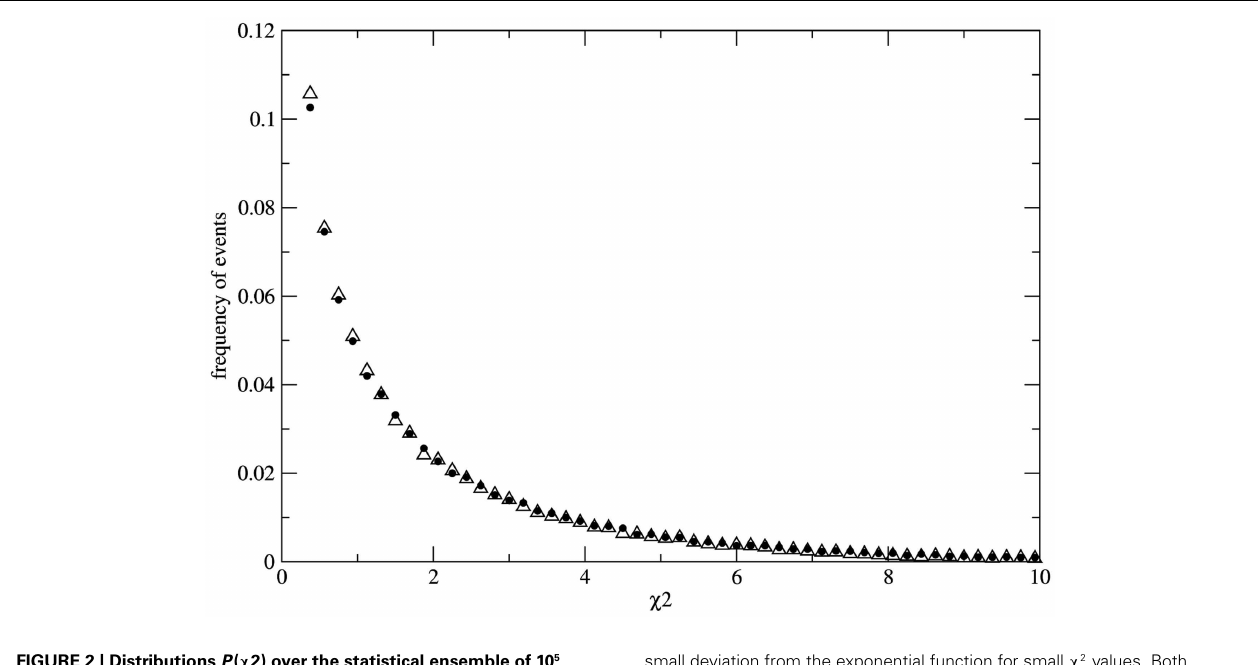
FIGURE 2 | Distributions P ( χ 2) over the statistical ensemble of 10 5 populations composed by 3.0 × 10 6 individuals each. The values of χ 2 are measured at fixed generation (simulation time unit) 30.The case of random mating (full dots) and the case of non-random mating (empty triangles) are well fitted by exponential distributions for χ 2 > 0.4 with a